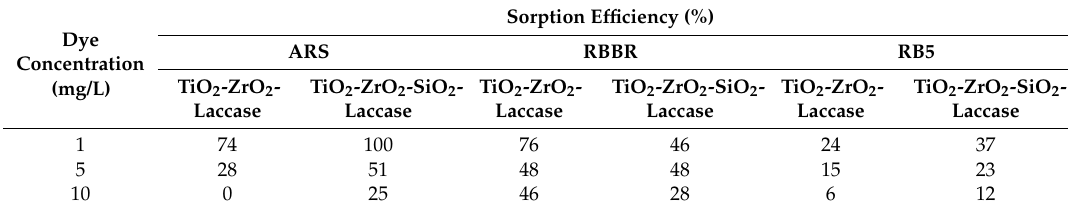
Table 2. Sorption efficiencies of dyes (Alizarin Red S (ARS), Remazol Brilliant Blue R (RBBR),